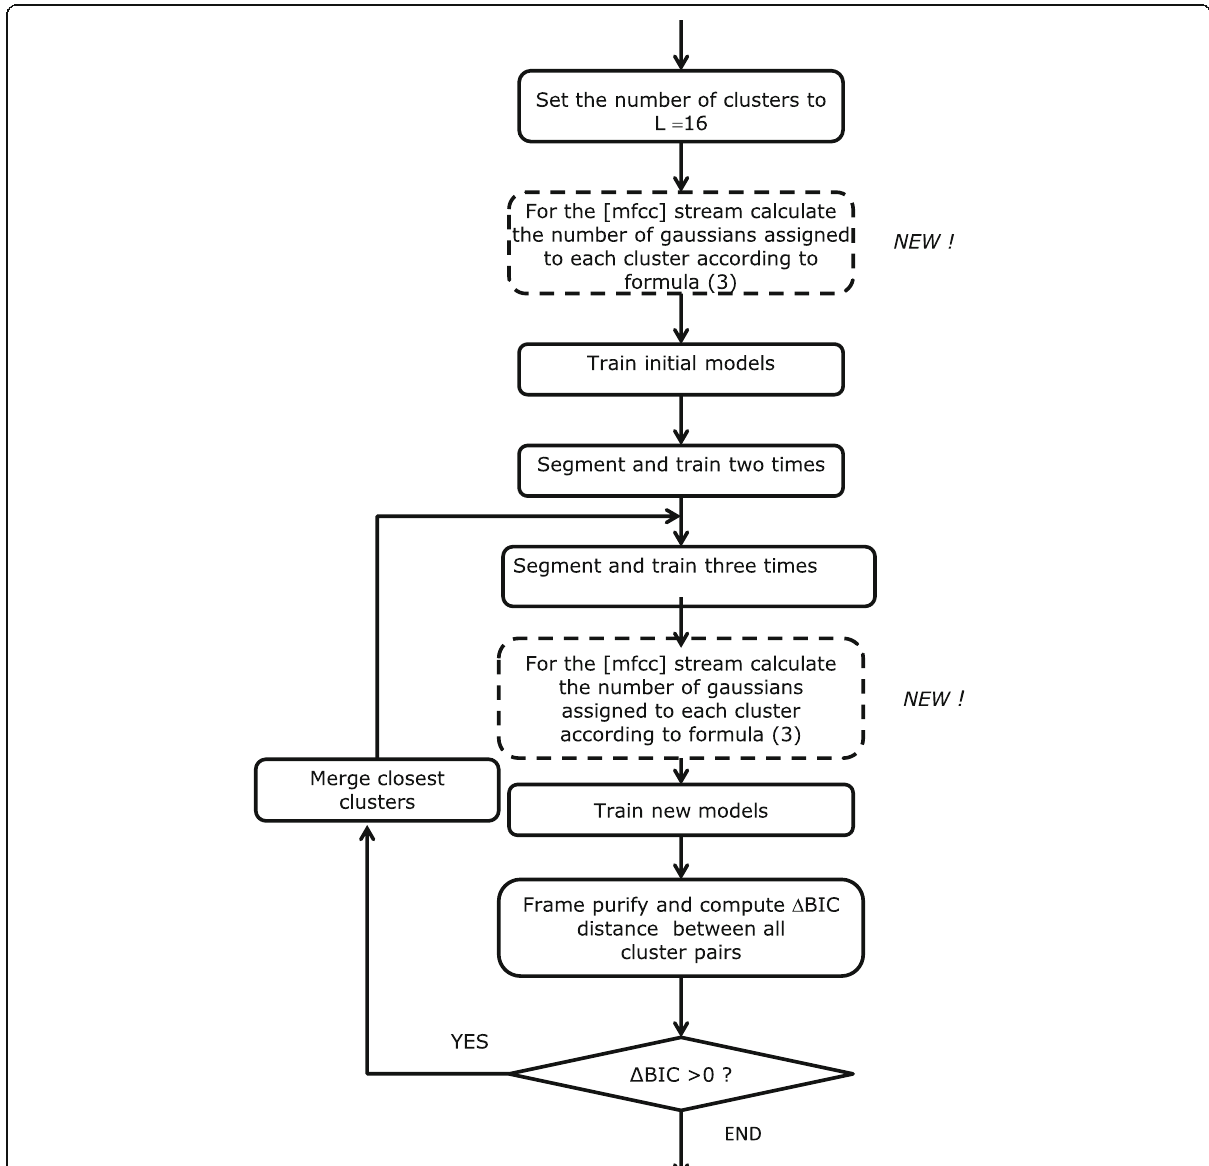
Fig. 10 Bloc diagram of the proposed algorithm. The changes to the baseline system are in dotted